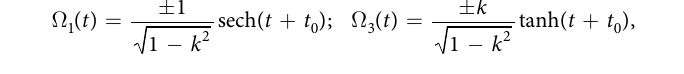
Figure 2. Dynamics of the angular momentum of a three-dimensional rigid body. Trajectories of the angular (cid:31)(cid:30) L of a three-dimensional rigid body in the body-fixed frame momentum red (light gray) lines depict respectively the rotating and oscillating trajectories of the angular momentum. The dashed line represents the separatrix. The parameter k is set to 0.5. In the case of a corresponding two-level quantum system, the trajectories represent the dynamics of the Bloch vector in the rotating